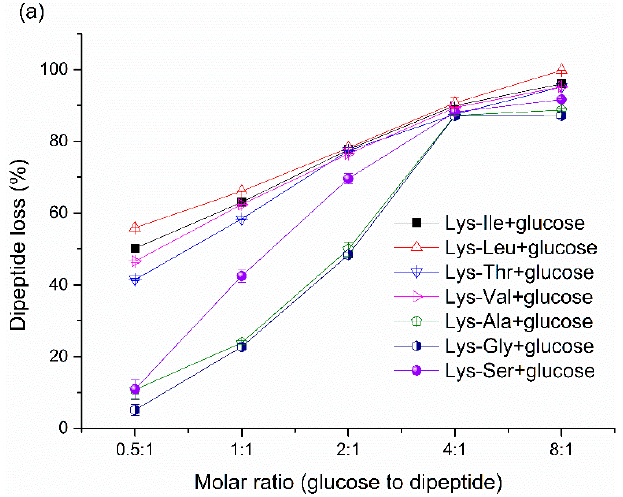
Figure 3. Cont . Figure 3.